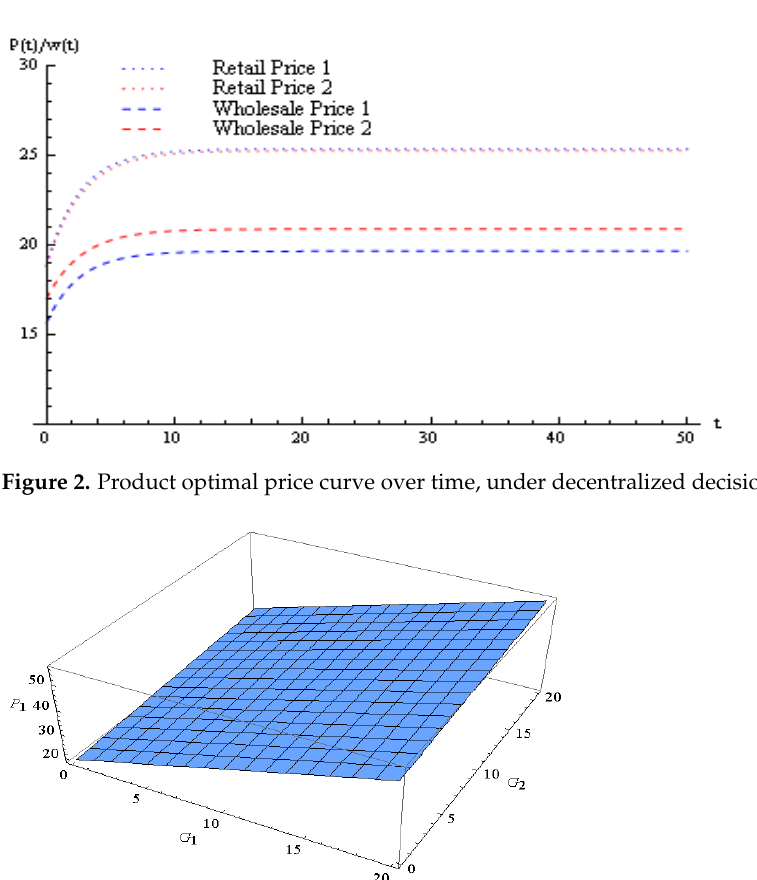
Figure 3. The impact of competitive product goodwill on the retail price of Product 1.